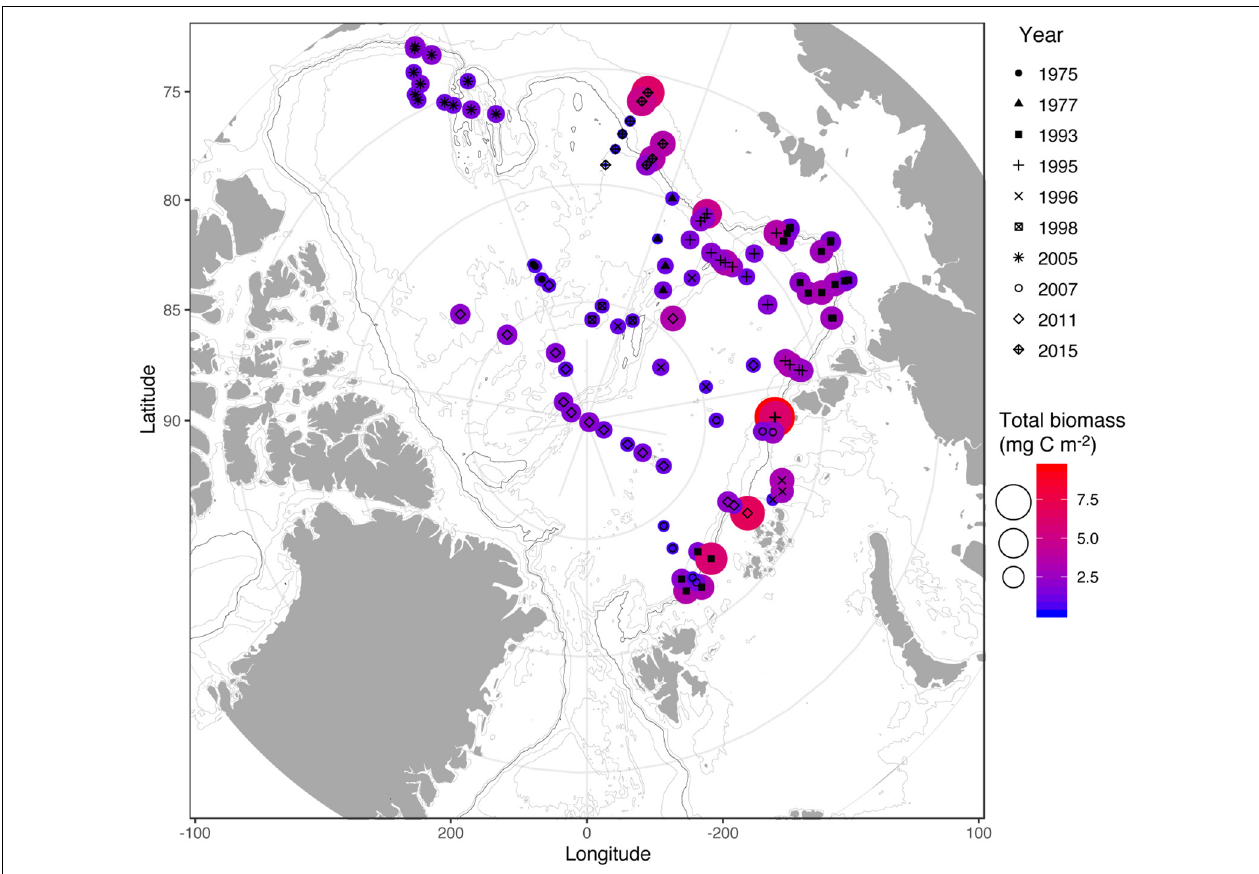
FIGURE 3 | Compilation of depth-integrated zooplankton biomass in the Arctic Ocean basins. Data were collected in the summer-autumn periods of 1975–2015 (data compiled from Kosobokova and Hirche, 2009; Bluhm et al., 2015; Ershova and Kosobokova, 2019) and converted from biomass (g dry weight m − 2 ) to carbon (g C m − 2 ) using the conversion of g C = 0.4 * g dry weight (Kiørboe, 2013). The 1000 m isobaths are depicted as a black